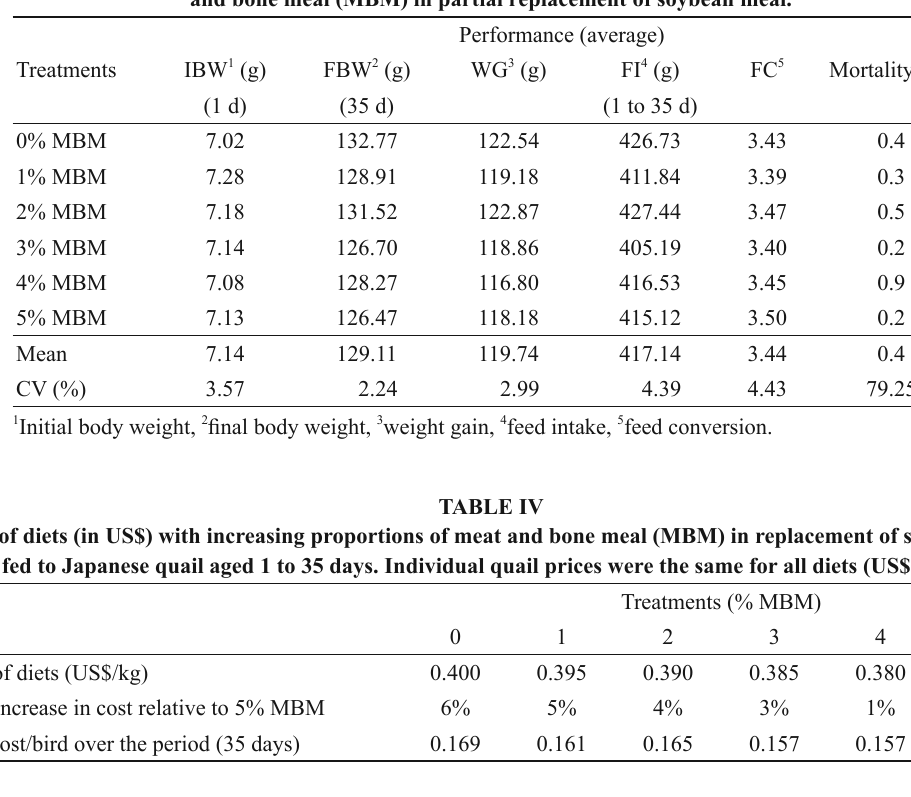
Performance of Japanese quail aged 1 to 35 days fed with diets with increasing proportion of meat and bone meal (MBM) in partial replacement of soybean meal.